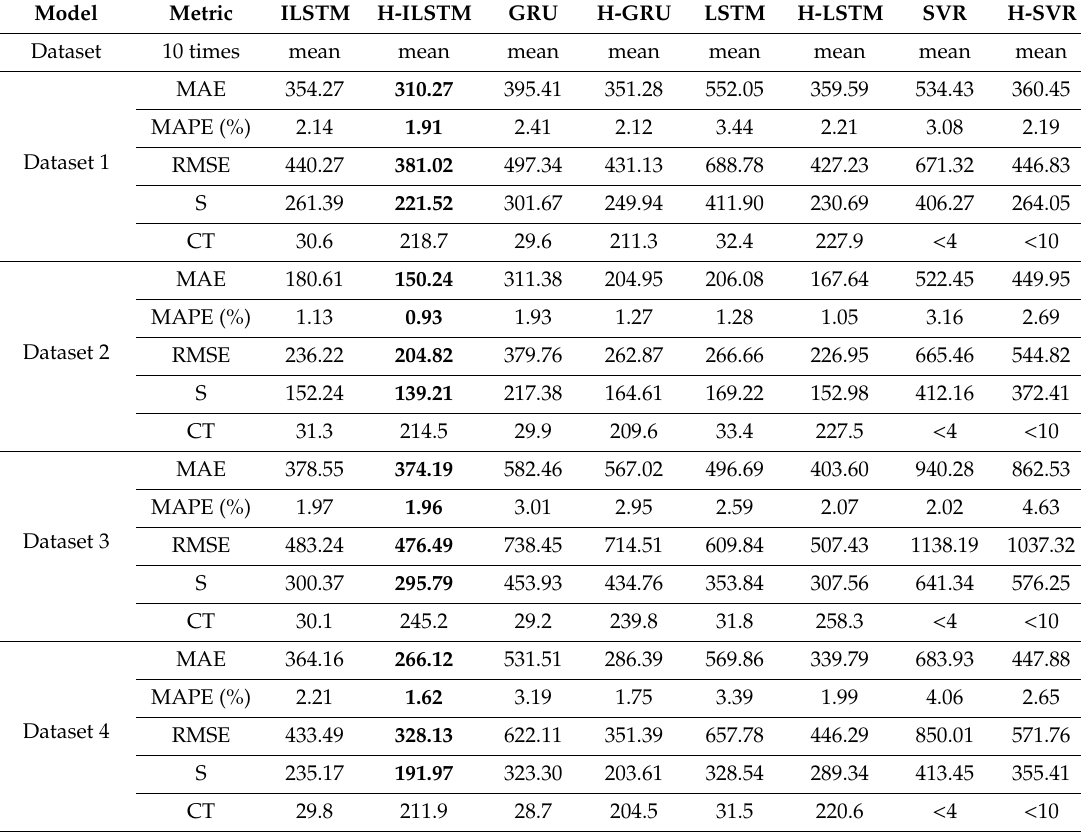
Figure 13. Coe ffi cient of determination by di ff erent methods for dataset 2. Table 9. The two-step prediction result of the load. (The bold characters in the table represent the best predictions among the eight